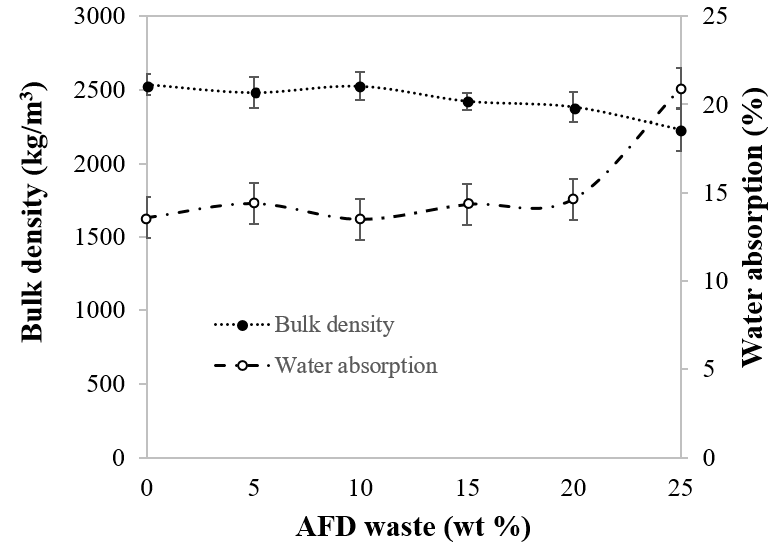
Figure 4. Bulk density and water absorption of fired bricks as a function of AFD waste content.